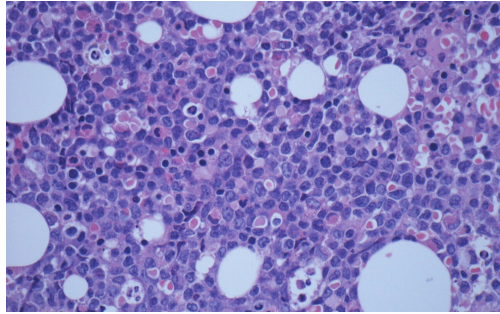
Figure 6: Bone marrow biopsy showing hypercellularity and atypical